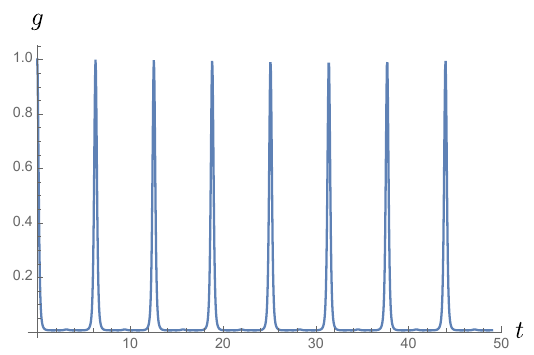
Figure 3 . Spectral form factor for a single free fermion with (cid:12) = : 5. The function is clearly periodic and does not demonstrate anything close to random matrix statistics. The recurrence time is 2 (cid:25) . studied. Consequently, we (cid:12)nd a di(cid:11)erent exponential scaling. Finally, in section 6, we discuss future directions in unifying the chaos